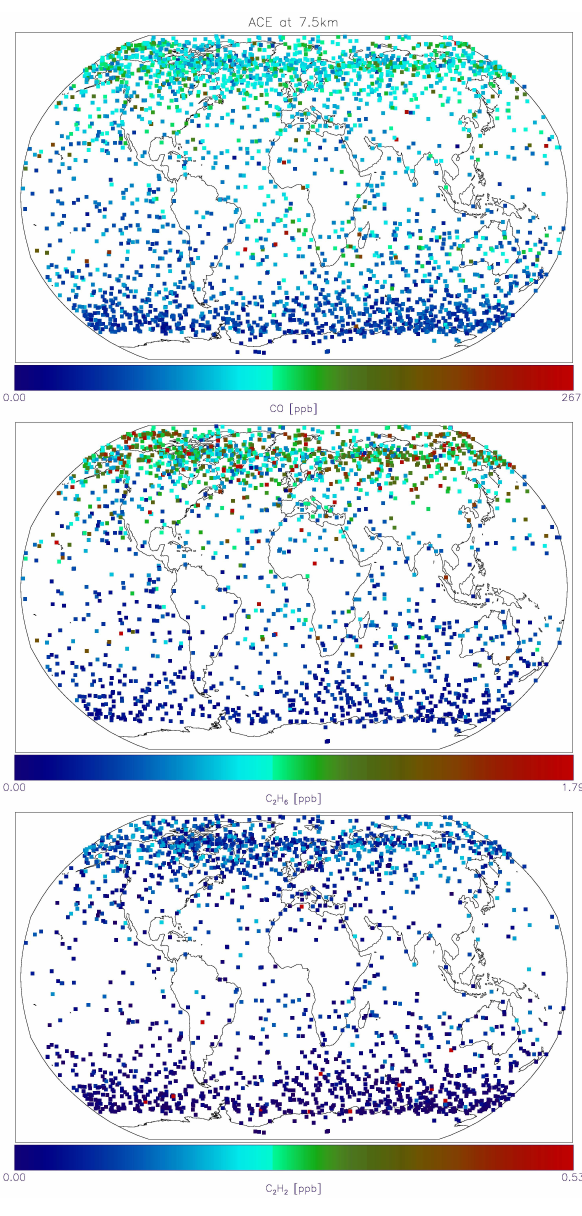
Fig. 7. CO, C 2 H 6 and C 2 H 2 concentrations at 7.5km retrieved using ACE-FTS spectra during the period between February 2004 and February 2007. Top panel CO, middle panel C 2 H 6 and bottom panel C 2 H 2 .